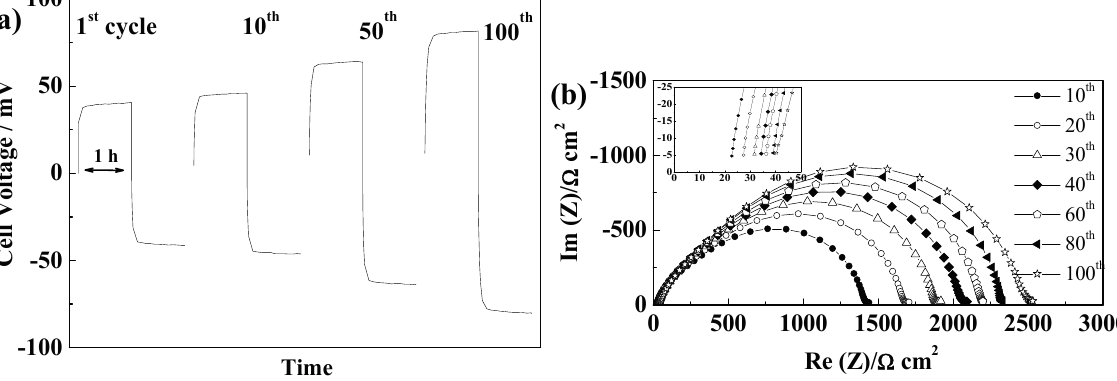
TFSI + Separion ® ) cell during cycling at 40 °C 14